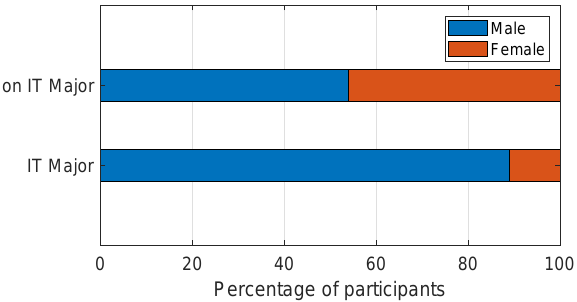
Figure 3. Gender distribution of student participants Among 881 participants, 465 are male and 336 were female. However, among the student participants, male to female radio widely varies depending on their major as shown in Figure